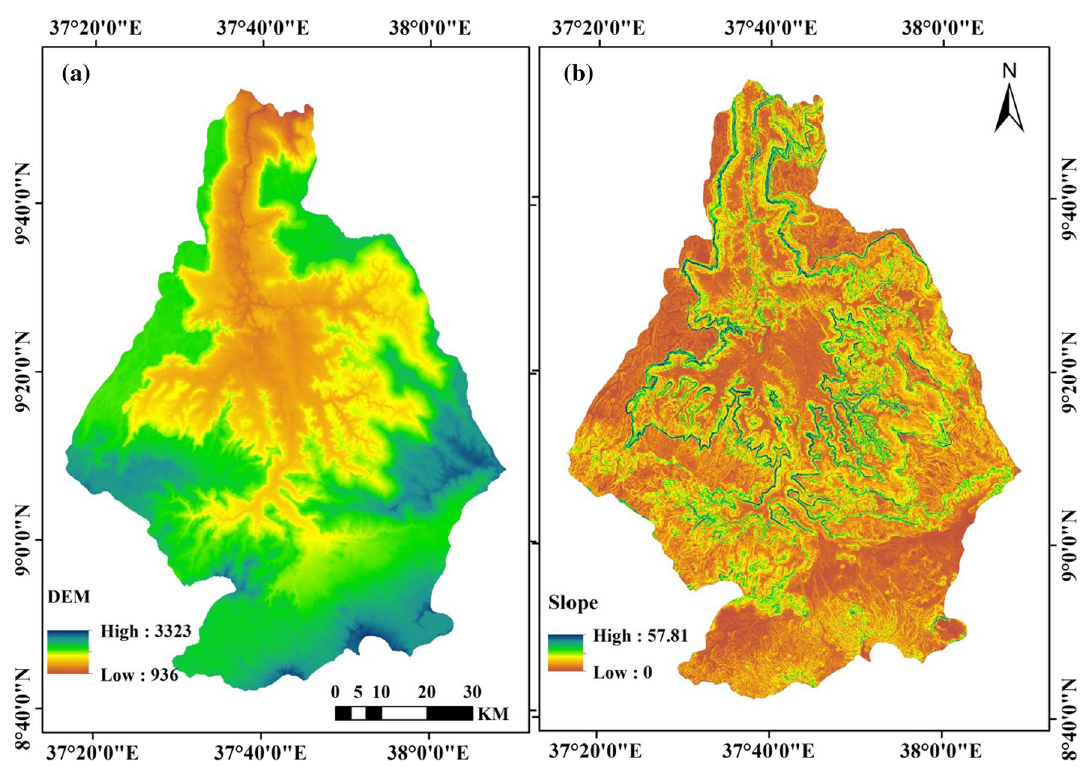
Fig. 2 a Digital elevation model (DEM). b Slope (in degrees) map of Guder